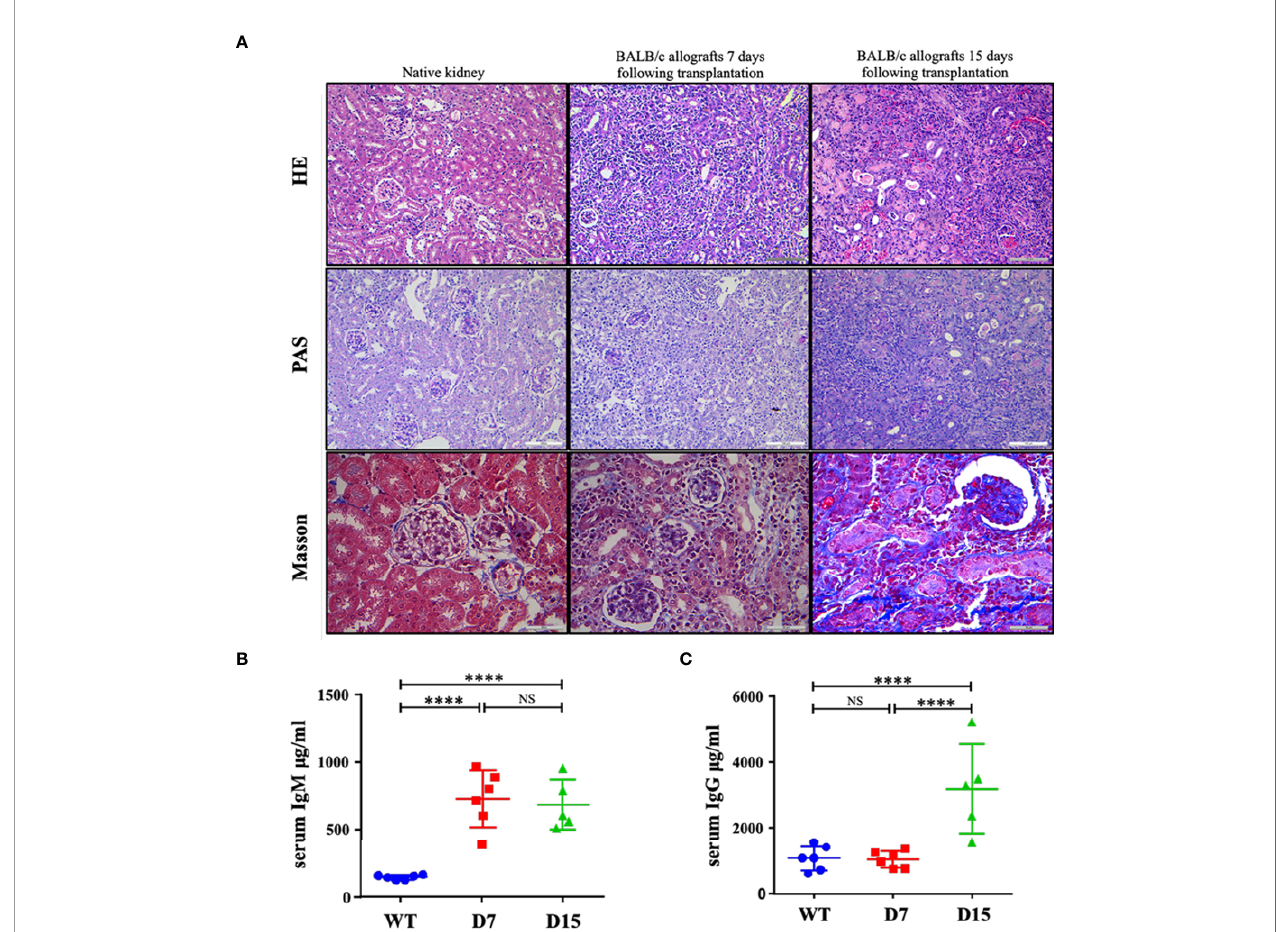
FIGURE 1 | Representative histological tubular injury in the transplanted kidneys. (A) Representative pictures of HE, PAS and Masson staining of native kidneys and allografted kidneys. Native kidneys do not exhibit tubular injury. Seven and 15 days following transplantation, BALB/c allografts undergo acute rejection with diffuse mononuclear cell in fi ltrates, perivascular lymphocytic in fi ltrates, necrotic tubules and tubulitis. Collagen fi bers were only noted in some parts of BALB/c allografts collected 15 days following transplantation as Masson staining showed. ELISA measurements of total (B) IgM and (C) IgG concentrations in serum from WT C57Bl6/ J mice (n = 6), kidney allograft recipients sacri fi ced on D7 (n = 6) and D15 (n = 5). WT, wild type; D7, 7 days following transplantation; D15, 15 days following transplantation. Data are presented as mean ± SD, and n represents number of mice. ****p < 0.0001. NS, not signi fi